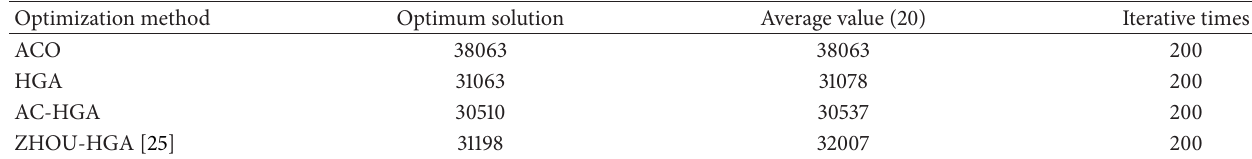
Table 3: The comparison of different